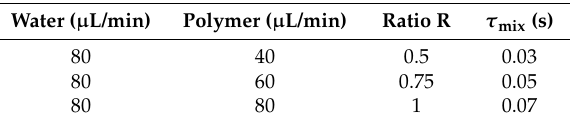
Figure 4. Size distribution of nanocapsules for the inlet flow rates. D, mean diameter. Table 1. Inlet flow rate and mixing time.